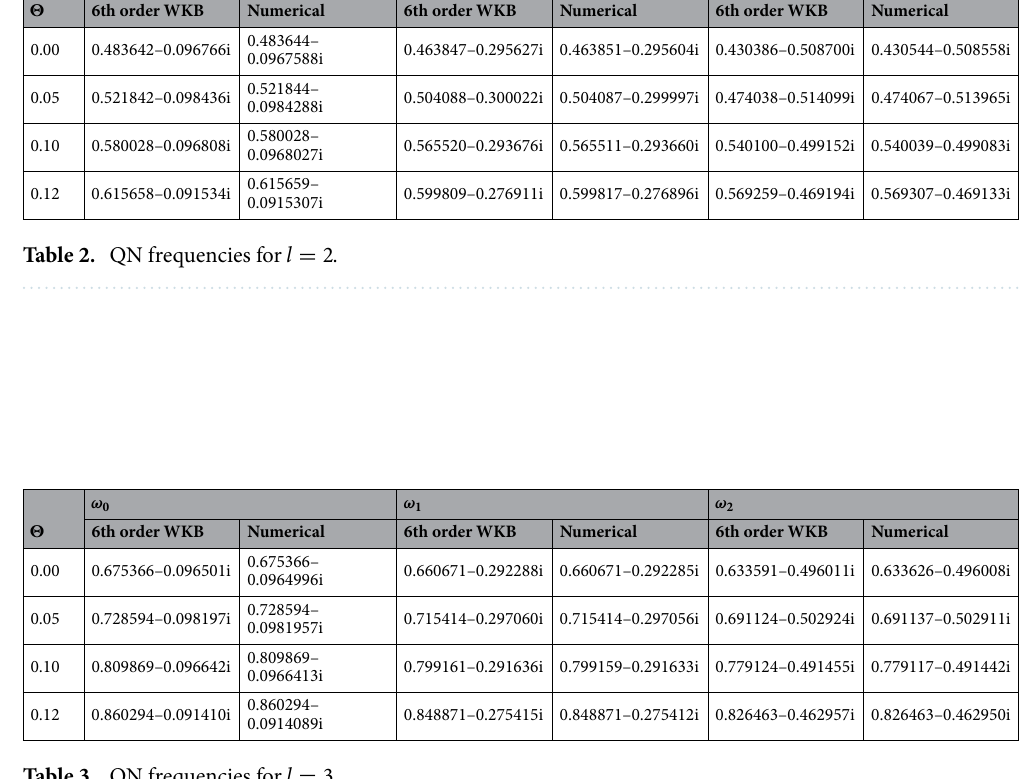
Table 3. QN frequencies for l = 3